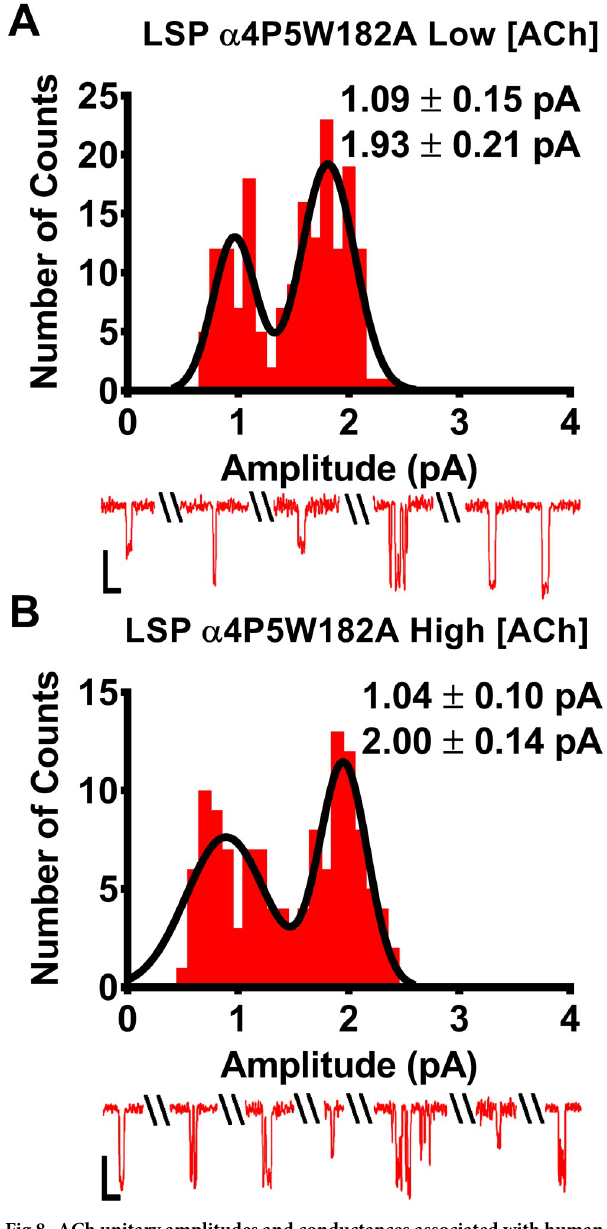
Fig 8. ACh unitary amplitudes and conductances associated with human LSP α 4P5W182A-nAChR expressed in X . laevis oocytes from pentameric, fully-concatenated constructs. All statistical comparisons for this figure were performed using two-tailed unpaired Student’s t-tests, df = 11–12, significant differences were noted at P < 0.05. (A) LSP α 4P5W182A-nAChR were stimulated with a low ACh concentration (0.7 μ M ACh). Evoked unitary responses produced openings that fell into two amplitude classes (small and large). These were statistically indistinguishable from those observed from LSP α 4 β 2-nAChR constructs that did not harbor the α 4P5W182A, when these were stimulated with the same concentration of ACh. (Fig 3B). (B) LSP α 4P5W182A-nAChR were stimulated with a high (30 μ M) ACh concentration. Single-channel openings displayed two amplitude classes that were indistinguishable from those in panel A using a low ACh concentration, and those of LSP-nAChR produced using the same high ACh concentration (Fig 3C). Example traces are shown below panels (A) and (B), demonstrating a mixture of individual openings at each amplitude level, and short bursts of activity followed by longer periods of inactivity. Values are given as mean ± S.E.M. Amplitude Data were collected across a minimum of three separate experiments from 7 patches, across a minimum of three separate experiments. All recordings were performed 3—6d following cRNA injection.